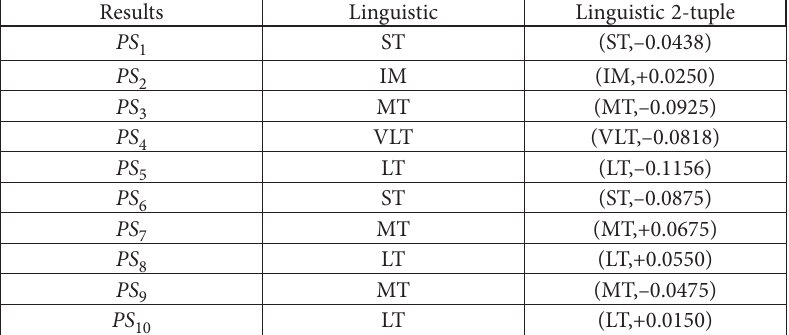
Table 4. Results obtained for the case study presented, expressed with different models